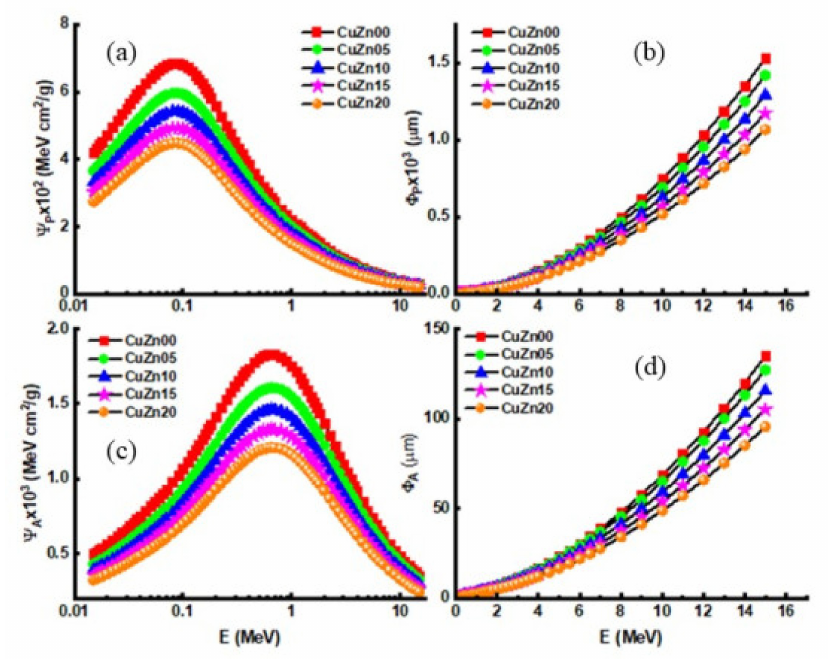
Figure 16. ( a ) Proton mass stopping power ( Ψ P ), ( b ) proton projected range ( Φ P ), ( c ) alpha mass stopping power ( Ψ A ) and ( d ) alpha projected range ( Φ A ) of